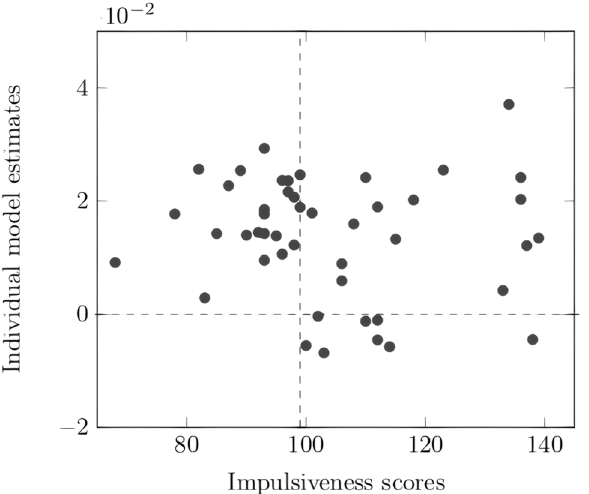
Figure 5. Individual estimates of the model according to the impulsiveness scores. The estimates of the model were used as an index of the capacity to adapt to task demands. The vertical dashed line represents the median of the UPPS score distribution that was used to create the low and the high impulsiveness groups. The horizontal dashed line represents the separation between negative slope (estimate < 0, no adaptation to task demands) and positive slope (estimate > 0, adaptation to task demands).